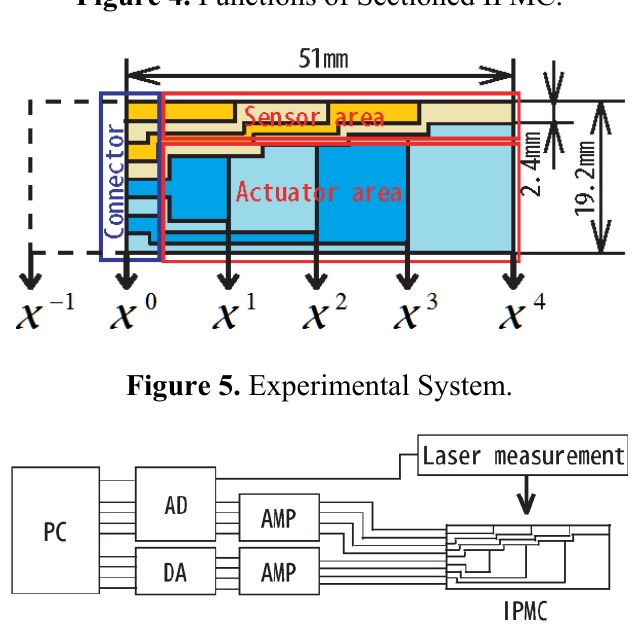
Figure 4. Functions of Sectioned IPMC.